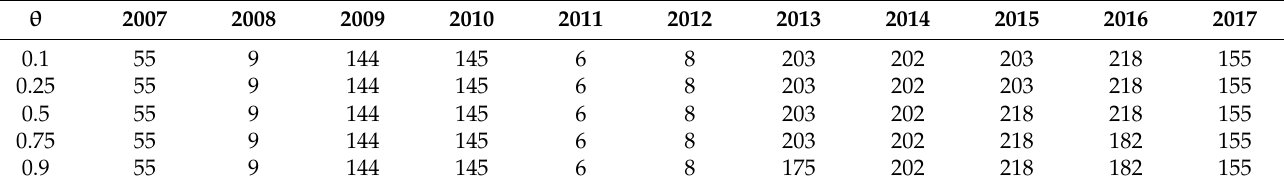
Table 6. Sensibility analysis for the chosen TTR at each iteration. (By the authors.)